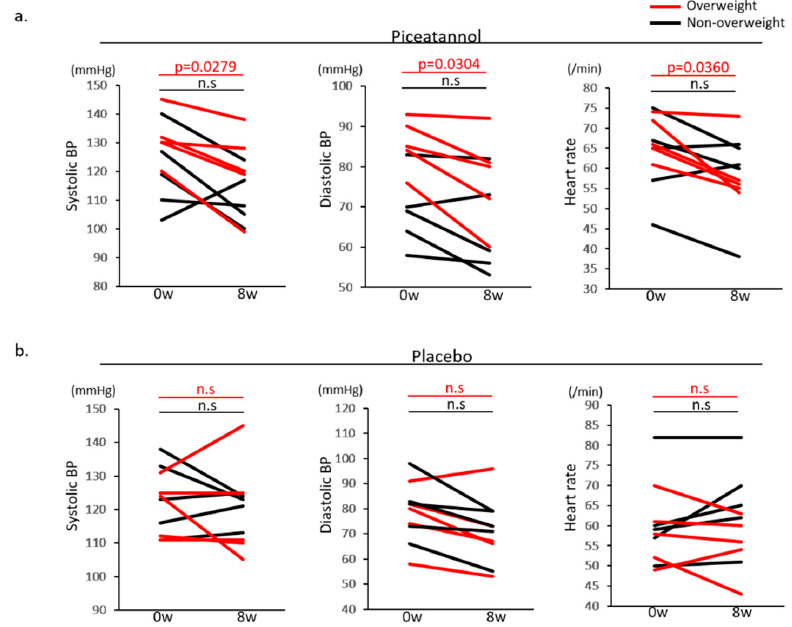
Figure 1. Systolic blood pressure (BP), diastolic BP and heart rate (HR) in overweight (shown as a red line) or non-overweight (shown as a black line) men at baseline and 8 weeks after piceatannol supplementation ( a ) or placebo ( b ). p values between two groups are shown, and n.s. denotes no significance.